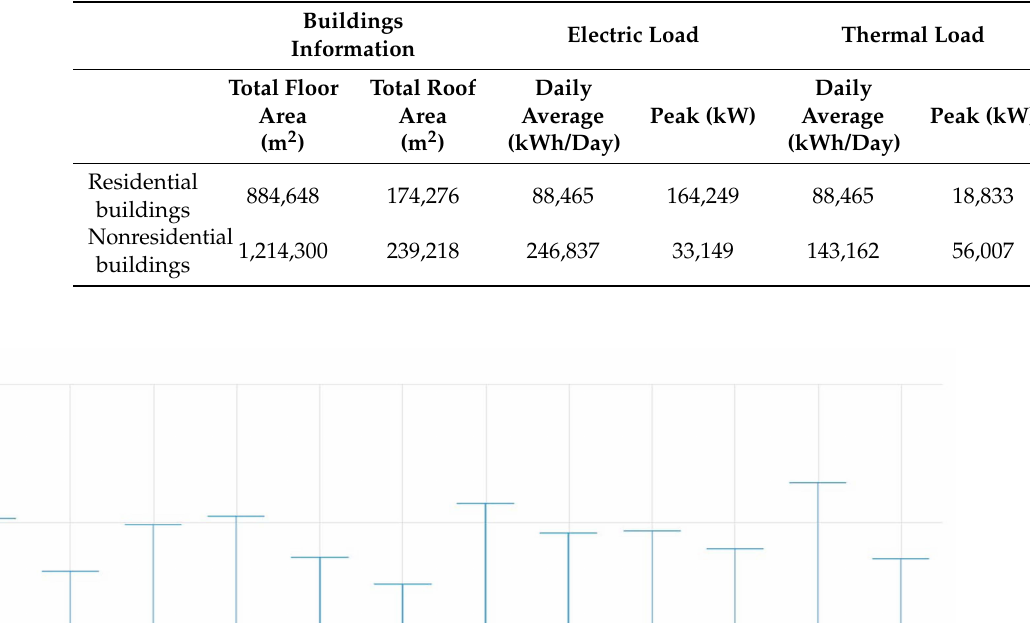
Table 1. Daily average and peak electric and thermal loads.